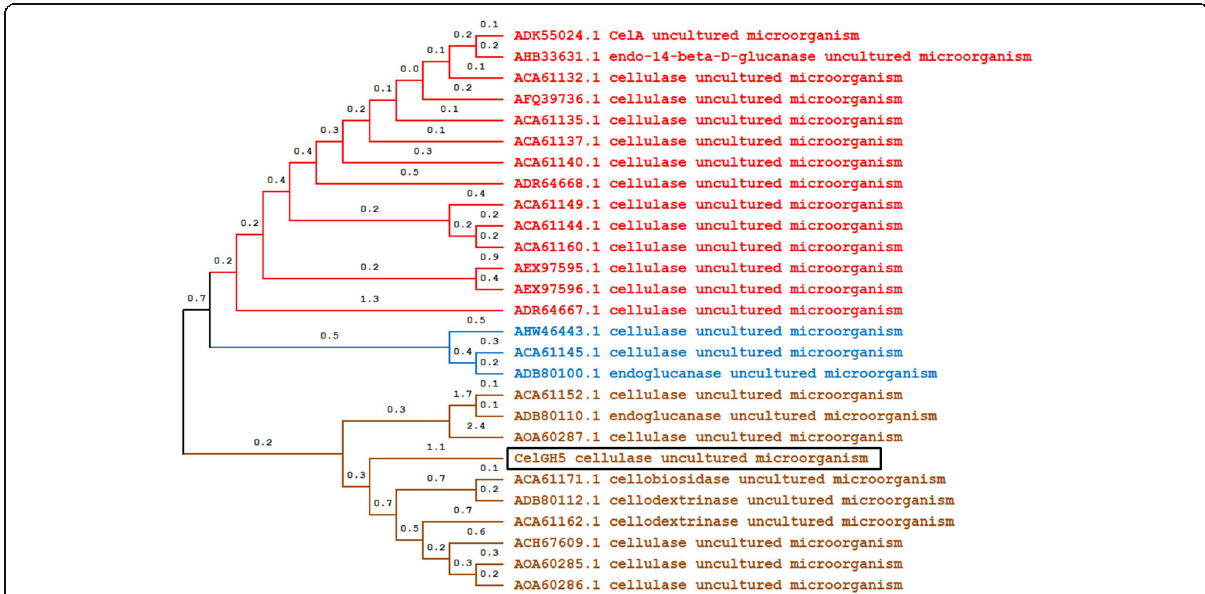
Fig. 9 The cladogram of 27 different amino acid sequences of the GH5-cellulase family from uncultured microorganism by maximum likelihood method based on JTT matrix model using MEGA X with bootstrap replications are 1000